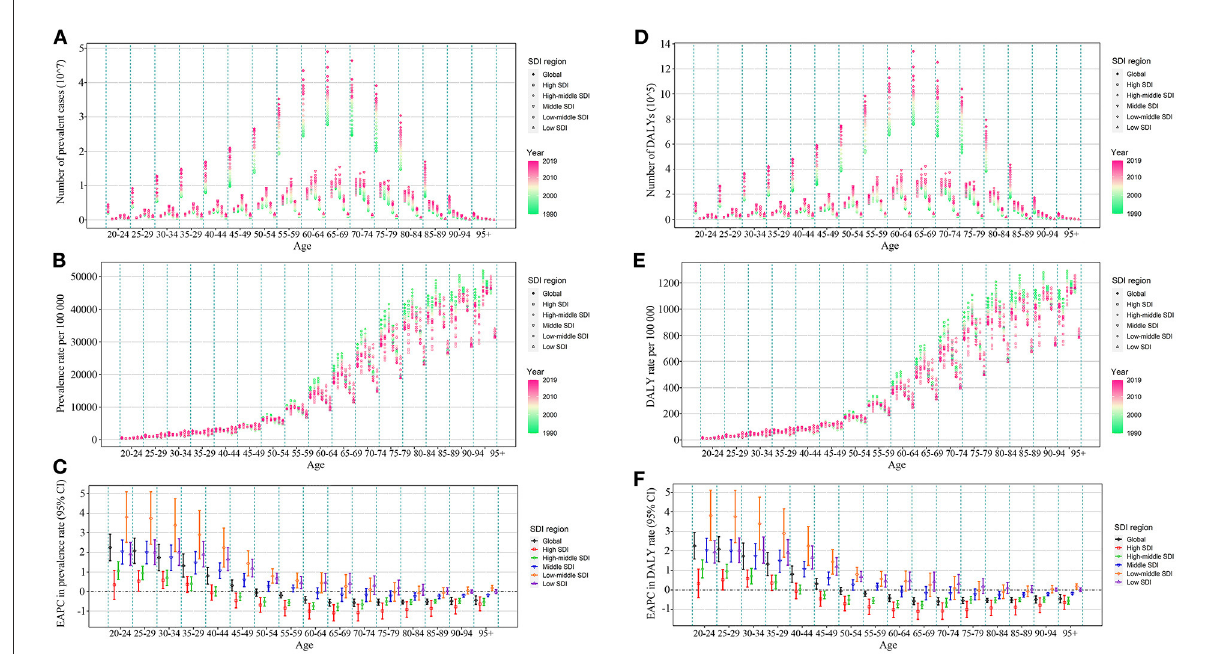
FIGURE3 Prevalent cases, prevalence rate, EAPC of prevalence rate, DALYs, DALY rate and EAPC of DALY rate of edentulism by age group, and SDI regions from 1990 to 2019. (A) Prevalent cases; (B) prevalence rate; (C) EAPC of prevalence rate; (D) DALYs; (E) DALY rate; (F) EAPC of DALY rate. DALYs, disability-adjusted life years; SDI, socio-demographic index; EAPC, estimated annual percentage change.